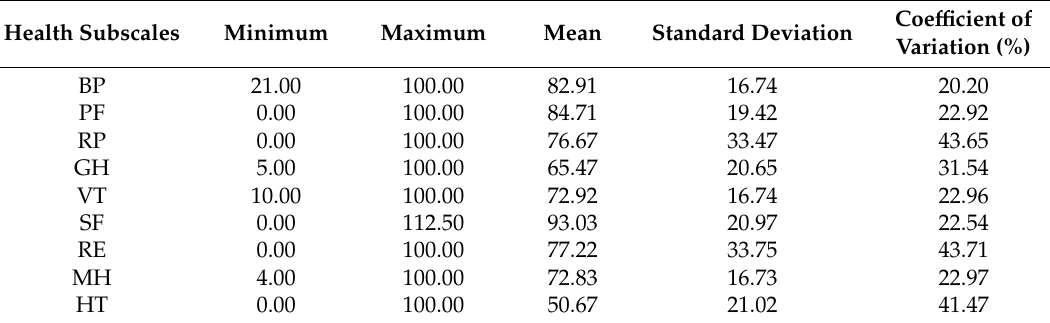
Table 3. SF-36 Basic scores for each subscale of the